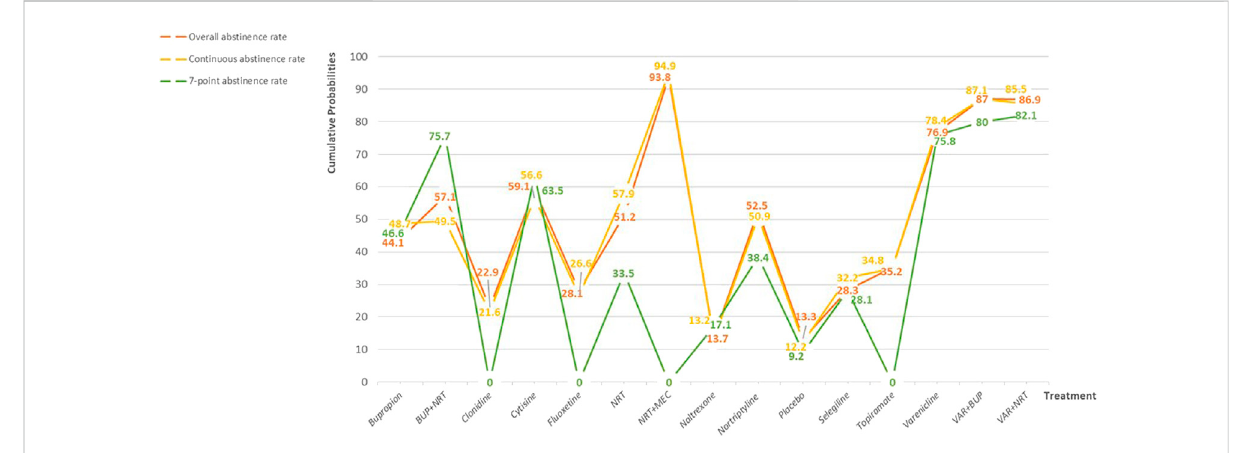
FIGURE 3 Probability ranking for all interventions. NRT: Nicotine replacement therapy; VAR: Varenicline; BUP: Bupropion.